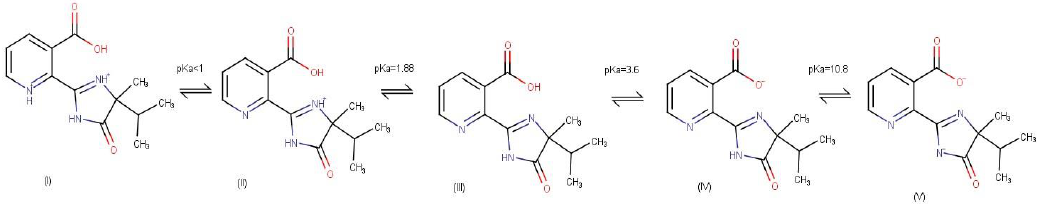
Figure 9. Imazapyr different forms as a function of the pH.